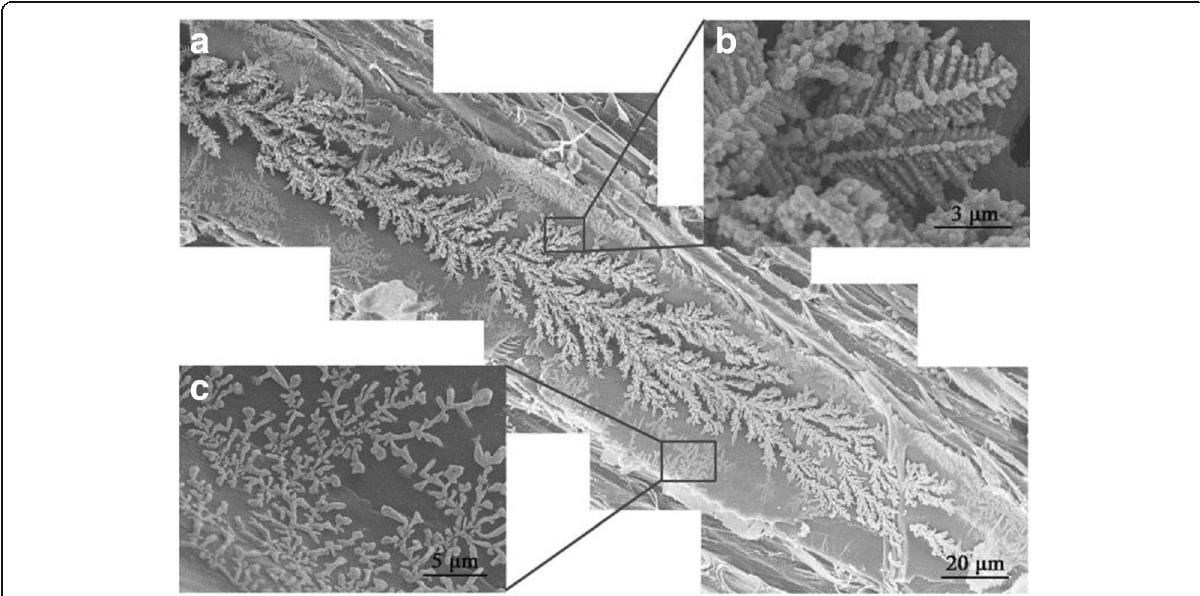
Fig. 5 FE-SEM observations of Cu NPs in poplar wood structure (group F). a The Cu nanostructures along wood cell lumen. b , c The magnifications of the Cu